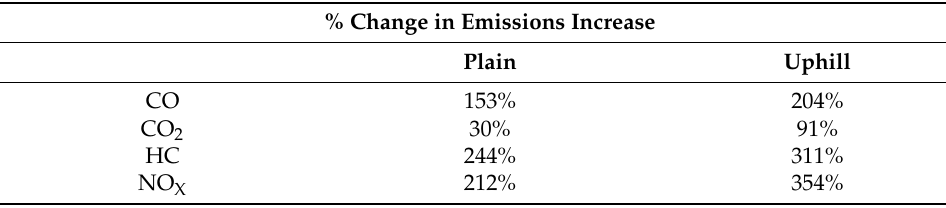
Table 4. Percentage changes in exhaust gas production